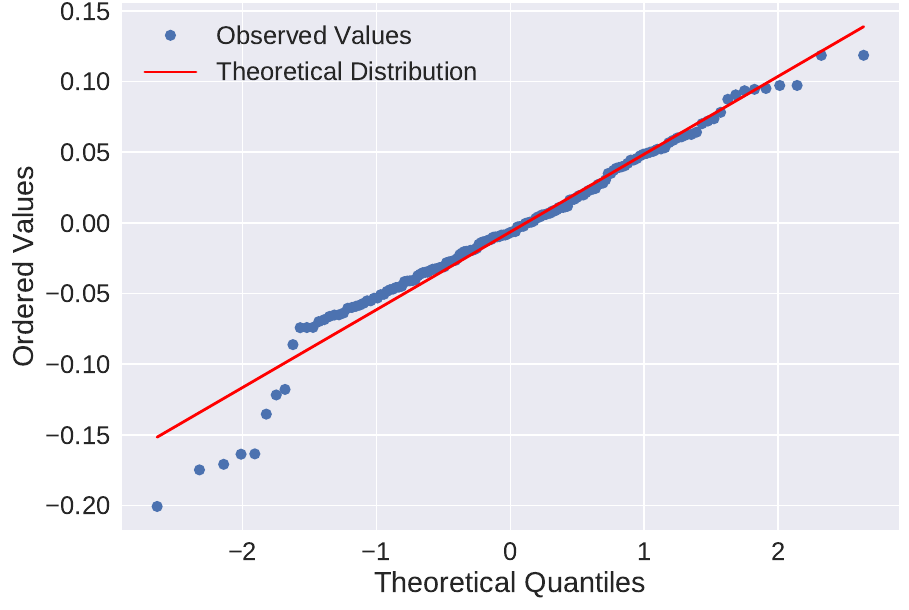
Figure 22. Variables distribution for SMAPE ≥